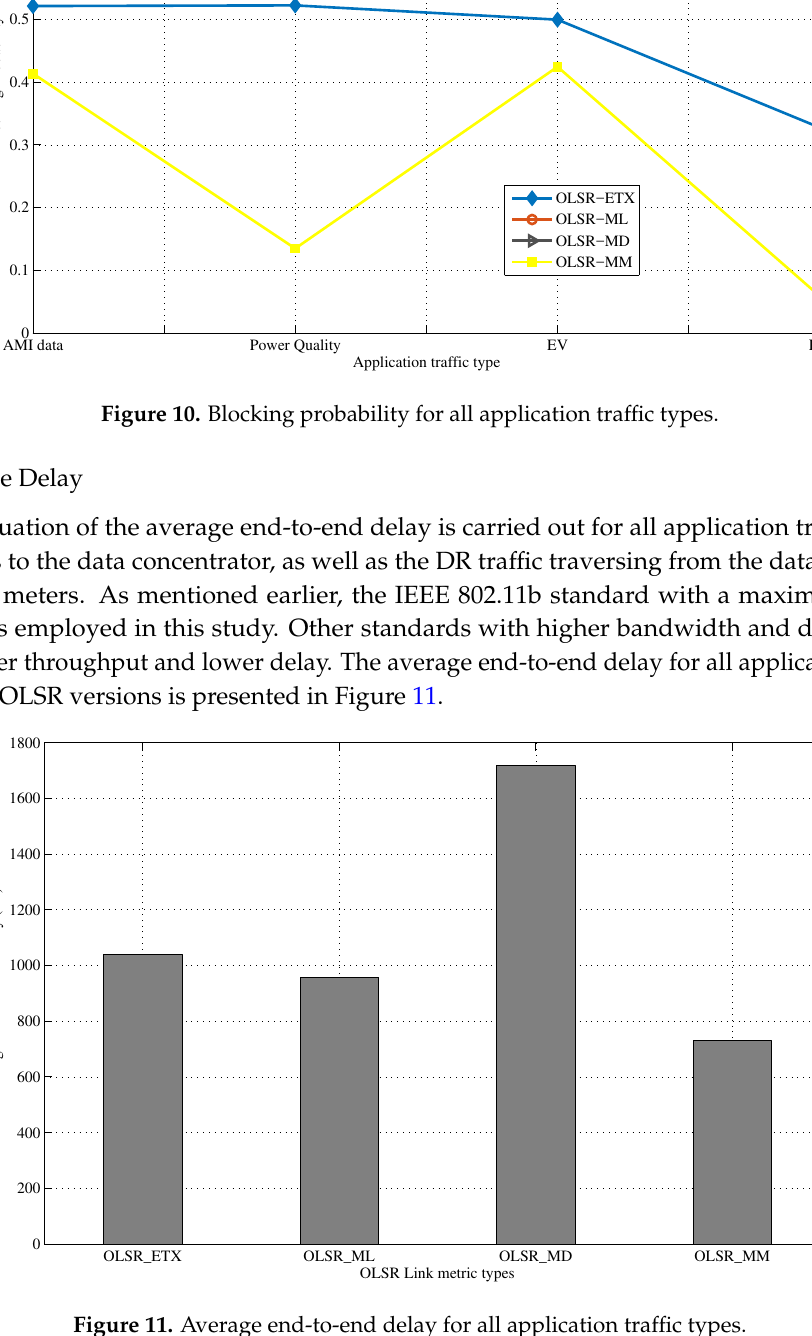
Figure 11. Average end-to-end delay for all application traffic